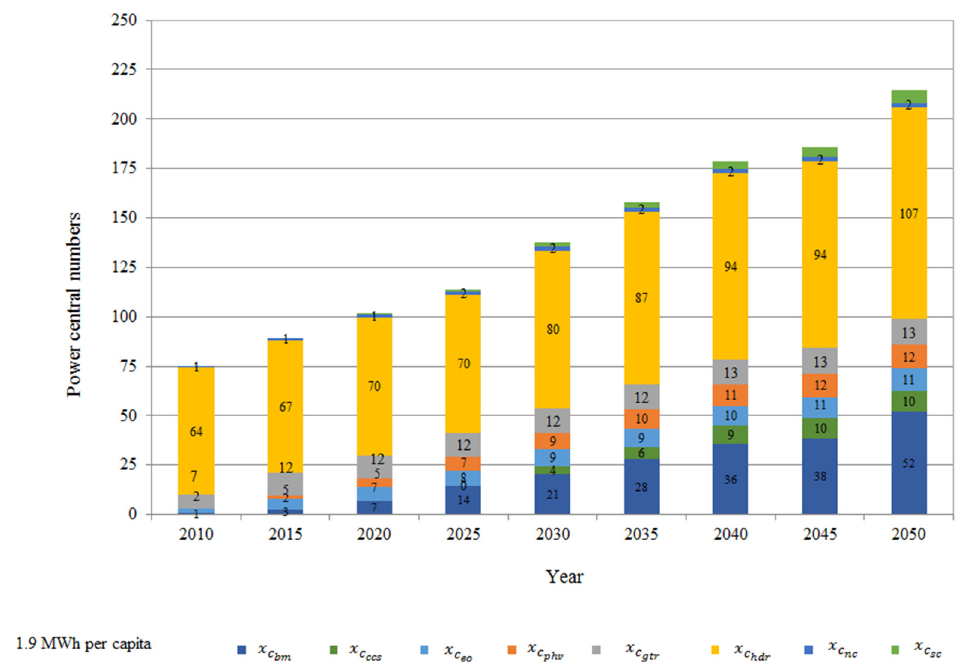
Figure 16. Optimized power plants number from clean energy resource for 1.9 MWh per capita demand with the CVF model.